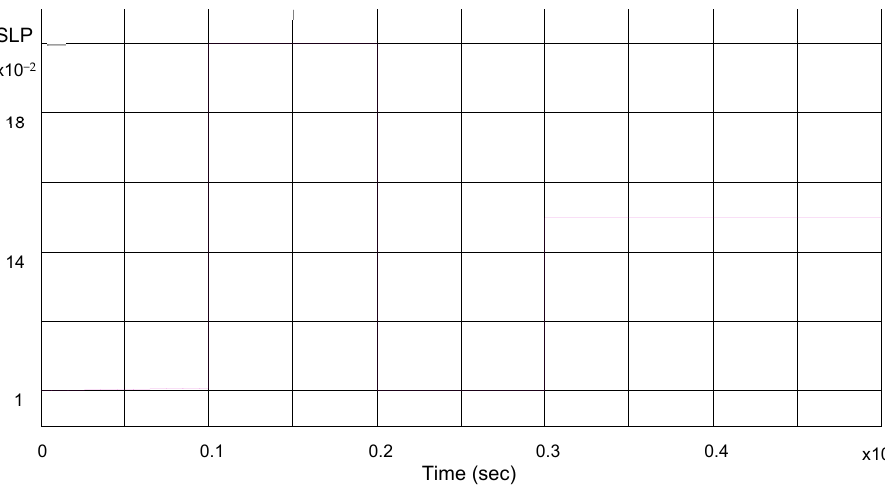
Figure 13. SLPs variations with time scale.